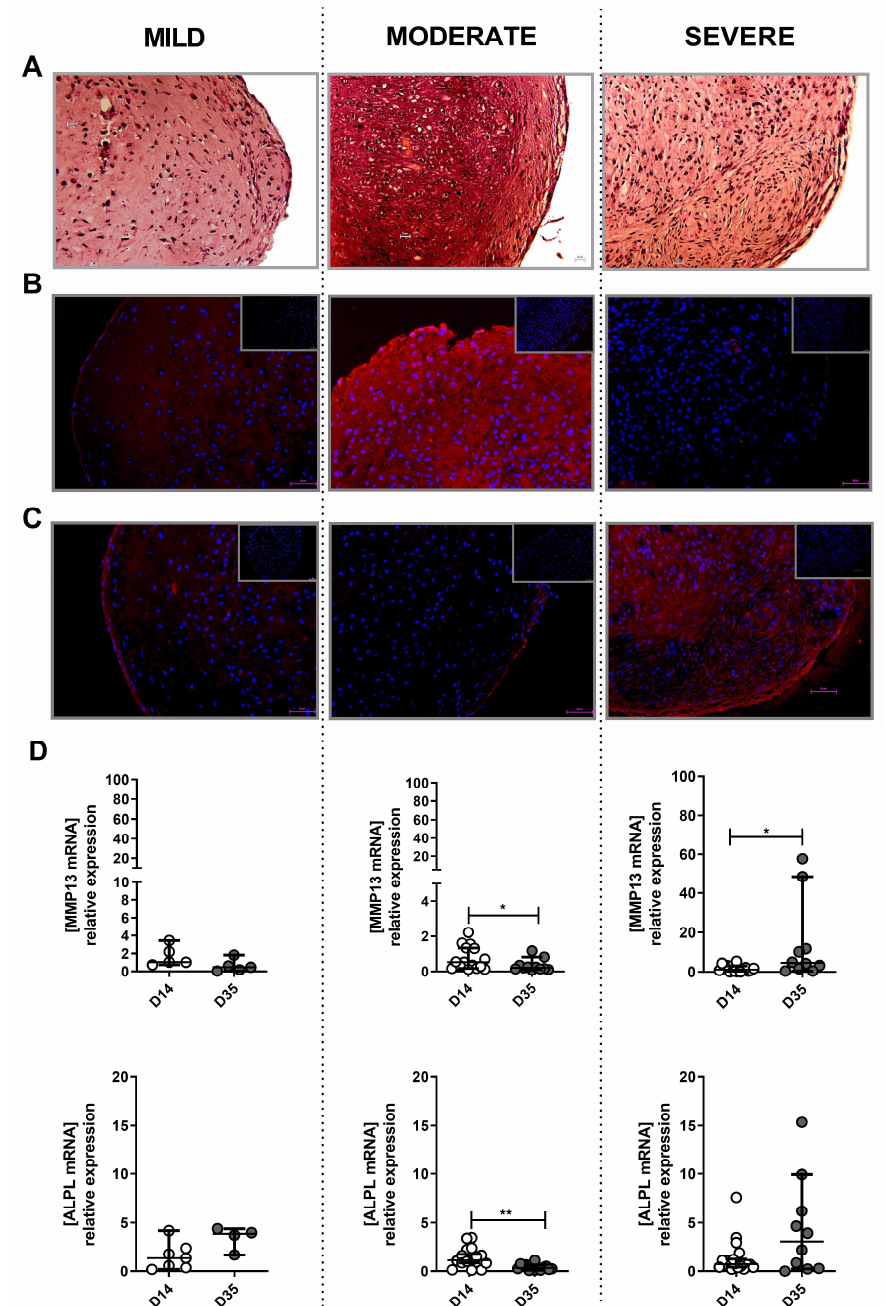
Figure 8. HES, Collagen II and I immunostaining of pellets of re-differentiated cells derived from mild, moderate and severe OA specimens. ( A ) Representative images of safranin O/hematoxylin/fast green of pellet sections derived from mild (left panel), moderate (middle panel) and severe (right panel) OA. ( B ) Representative images of immunofluorescence of Collagen II on pellet sections derived from mild (left panel), moderate (middle panel) and severe (right panel) OA samples. ( C ) Representative images of immunofluorescence of Collagen I on pellet sections derived from mild (left panel), moderate (middle panel) and severe OA tissues (right panel). Representative images of negative control (without primary antibody) are presented in the right corner of each IHC representative image. ( D ) Changes in MMP13 and ALPL mRNA expression levels between D14 and D35 in mild (left panel), moderate (middle panel) and severe OA (right panel) derived cells. * p < 0.05, ** p < 0.01, non-parametric Kruskal–Wallis and Mann–Whitney test were